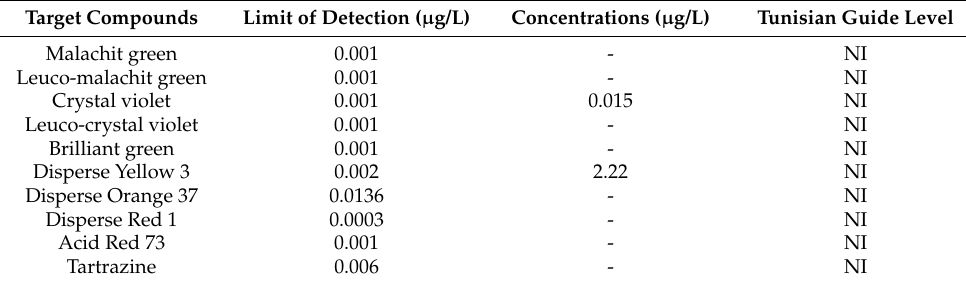
Table 2. Concentrations of textile dyes analyzed in the TDE